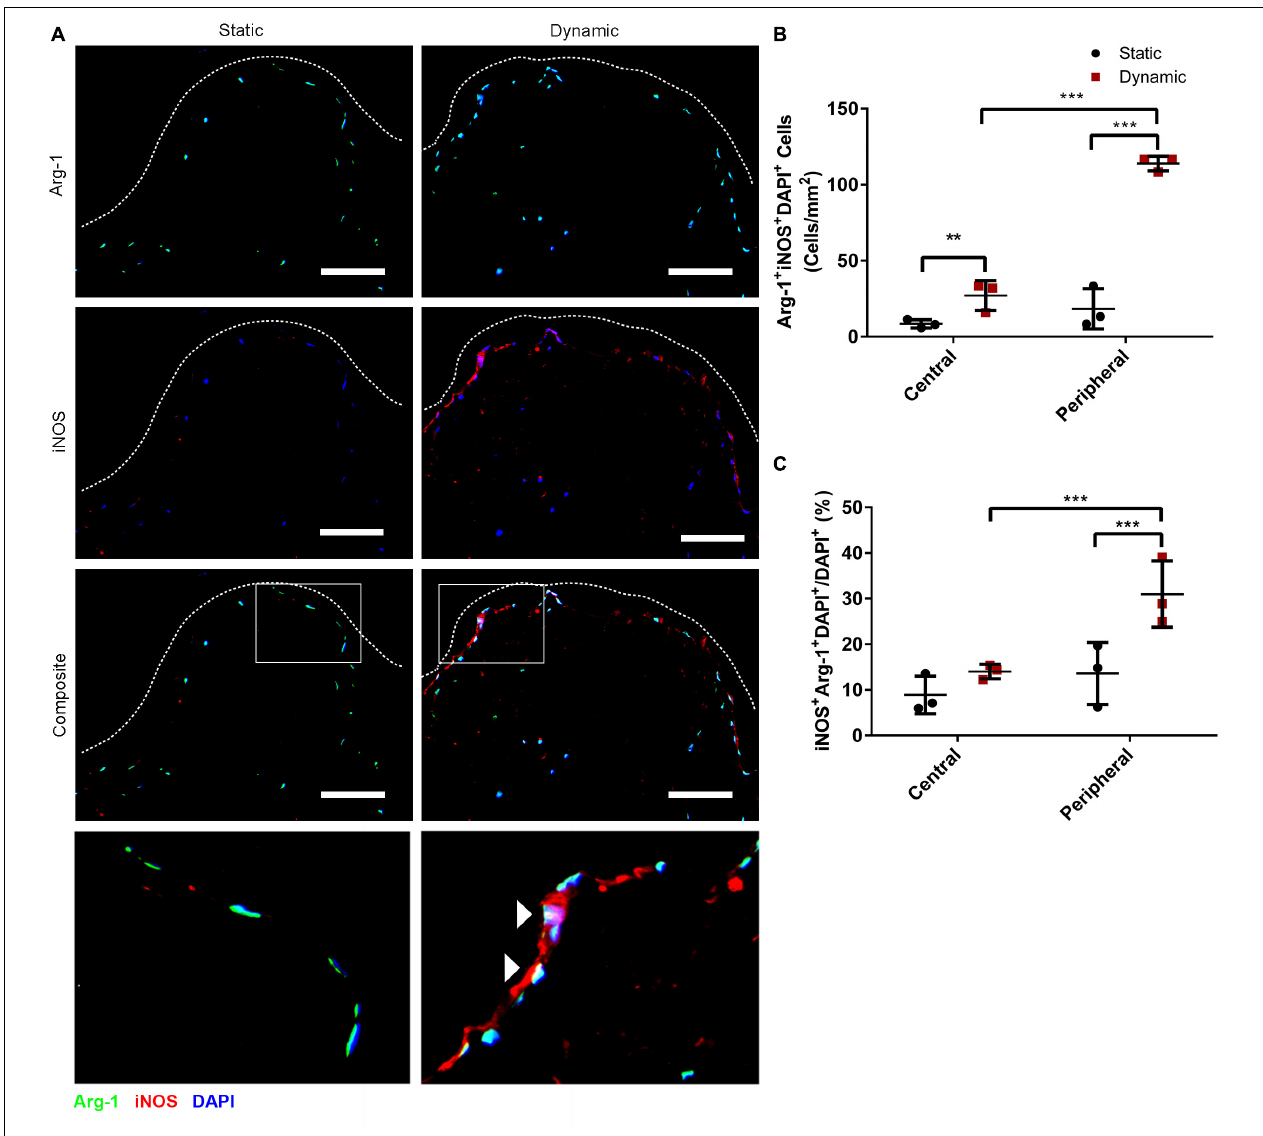
FIGURE 1 | Dynamic culture within the perfusion bioreactor for 14 days increased the percentage of human ASCs co-expressing iNOS and Arg-1 within the peripheral region of the DAT scaffolds. (A) Representative immunostaining for Arg-1 (green) and iNOS (red) with DAPI (blue) for the static and dynamic groups at 14 days. Dashed lines indicate the edge of the DAT scaffolds. Scale bars represent 100 µ m. Boxed regions in the composite images are shown at higher magnification below. White arrowheads highlight Arg-1 + iNOS + DAPI + cells. (B) The density of iNOS + Arg-1 + DAPI + cells and (C) the percentage of iNOS + Arg-1 + DAPI + cells relative to the total DAPI + cell population in the central ( > 200 µ m from scaffold edge) and peripheral ( < 200 µ m from scaffold edge) regions of the DAT scaffolds cultured statically or dynamically. ** p < 0.01, *** p <